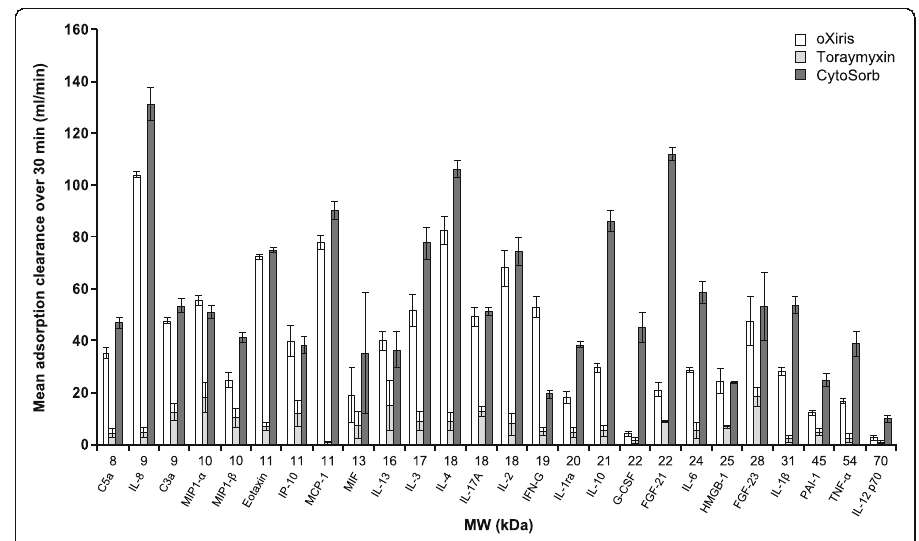
Fig. 4 Mean adsorption clearances over 30 min for the inflammatory mediators included in the study. Abbreviations : C3a complement 3a, C5a complement 5a, FGF fibroblast growth factor, G-CSF granulocyte-colony stimulating factor, HMGB-1 high-mobility group box 1 protein, IFN interferon, IL interleukin, IP interferon-induced protein, MCP monocyte chemoattractant protein, MIF macrophage migration inhibitory factor, MIP macrophage inflammatory protein, PAI plasminogen activator inhibitor, TNF tumor necrosis factor, Ra receptor agonist, α alpha, β beta, γ